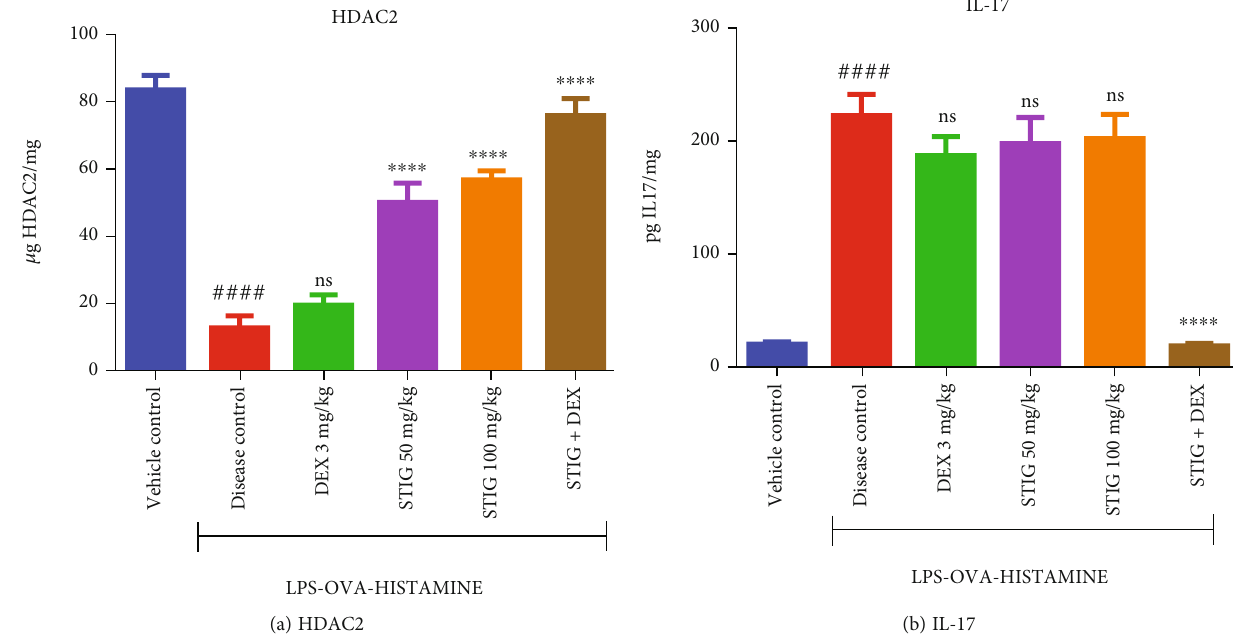
Figure 6: E ff ect of STIG and STIG+DEX on HDAC2 and IL-17 levels. Data is expressed as mean ± SEM ( n = 5 ). #### p < 0 : 0001 compared to the vehicle control group; ∗∗∗∗ p < 0 : 0001 , and ns (not signi fi cant) as compared to the disease control group with one-way ANOVA followed by Dunnett ’ s post hoc